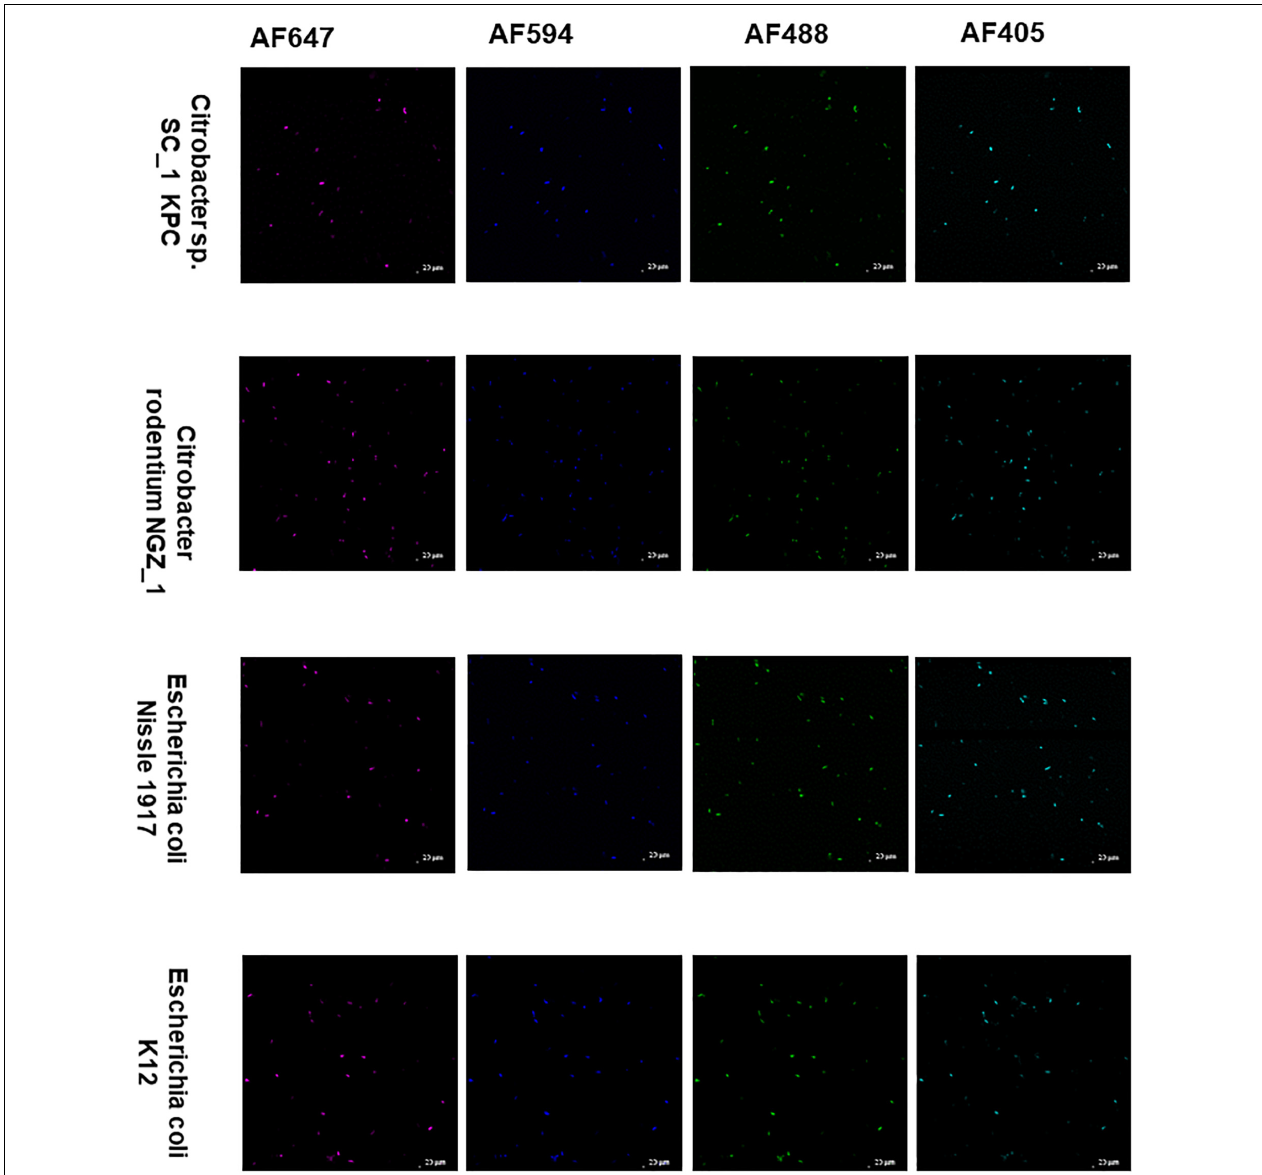
FIGURE 5 | COMBICK enables multi-fluorophore labeling of different Enterobacteriaceae species using confocal microscopy. Labeling of different Enterobacteriaceae species with several fluorophores simultaneously (AF647, AF4594, AF488, and AF405). Each column represents a different fluorophore channel. Confocal images representing labeled Enterobacteriaceae species with 4 fluorophores simultaneously.